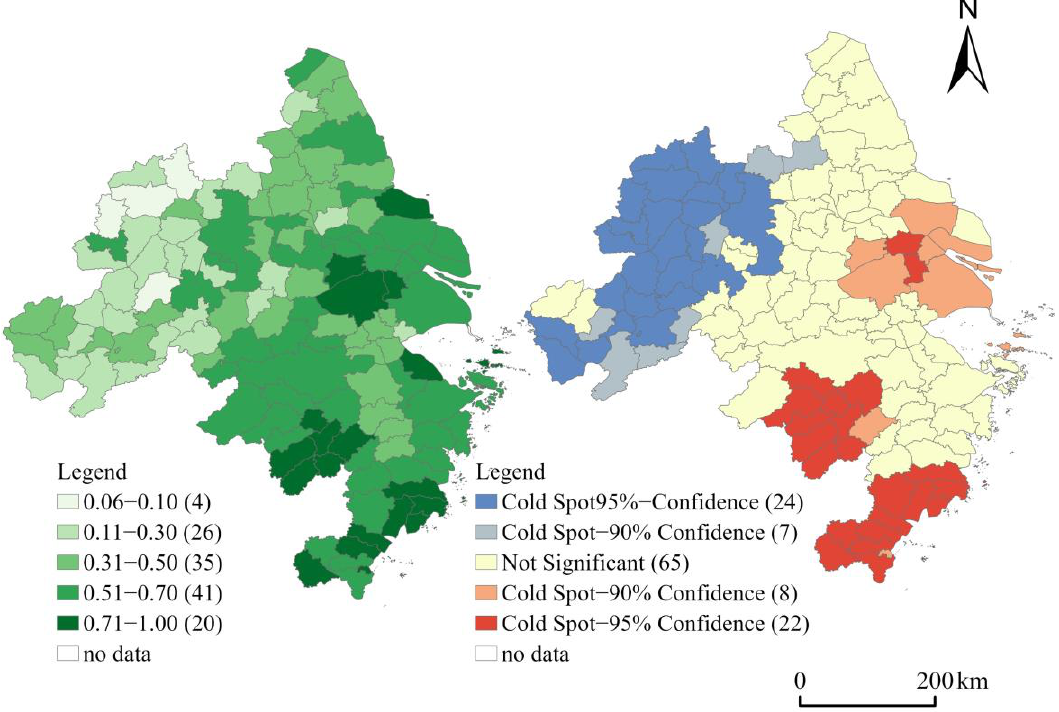
Figure 3. Analysis of land urbanization pattern and hot spots in Yangtze River Delta urban agglomeration in 2010.